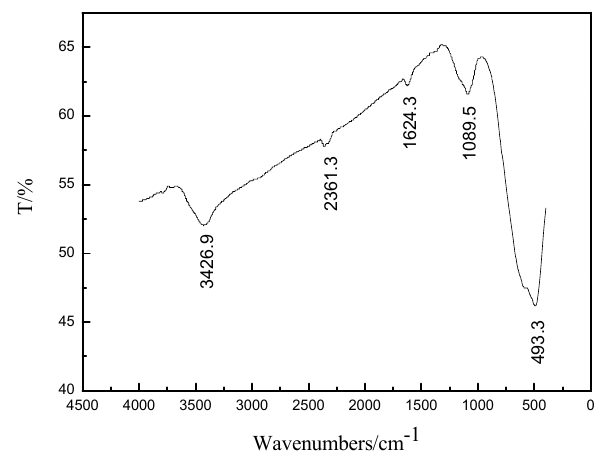
Figure 6. Raman spectra of titania